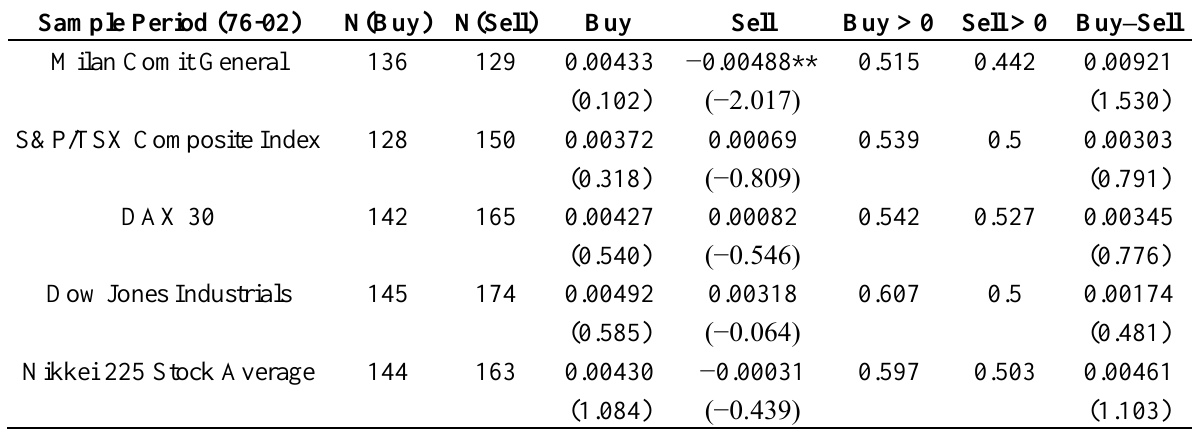
Table 3B. Average ten-day returns from RSI (14, 50).